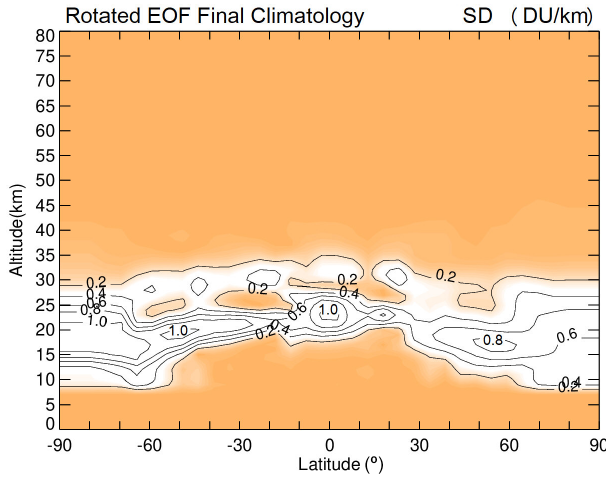
Figure 6. Temporal standard deviation (in DUkm − 1 ) for 1970– 2018 for the final REOF ozone climatology (i.e., Eq. S10 in the Sup- plement). The interannual variability in the tropical low latitudes is almost entirely due to the QBO. Interannual variability in the extra- tropics comes from the QBO coupled with other non-QBO-related interannual